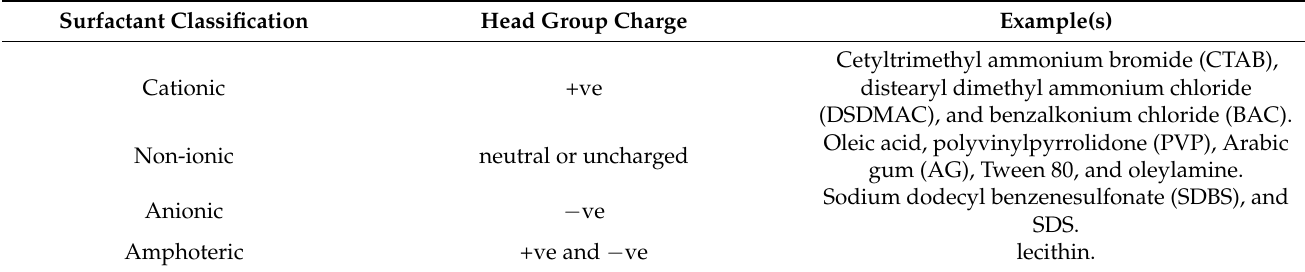
Table 3. Examples of surfactants used in nanofluids fabrication categorized by classifications based on their head group charge. Surfactant Classification Head Group Charge Example(s) Cationic